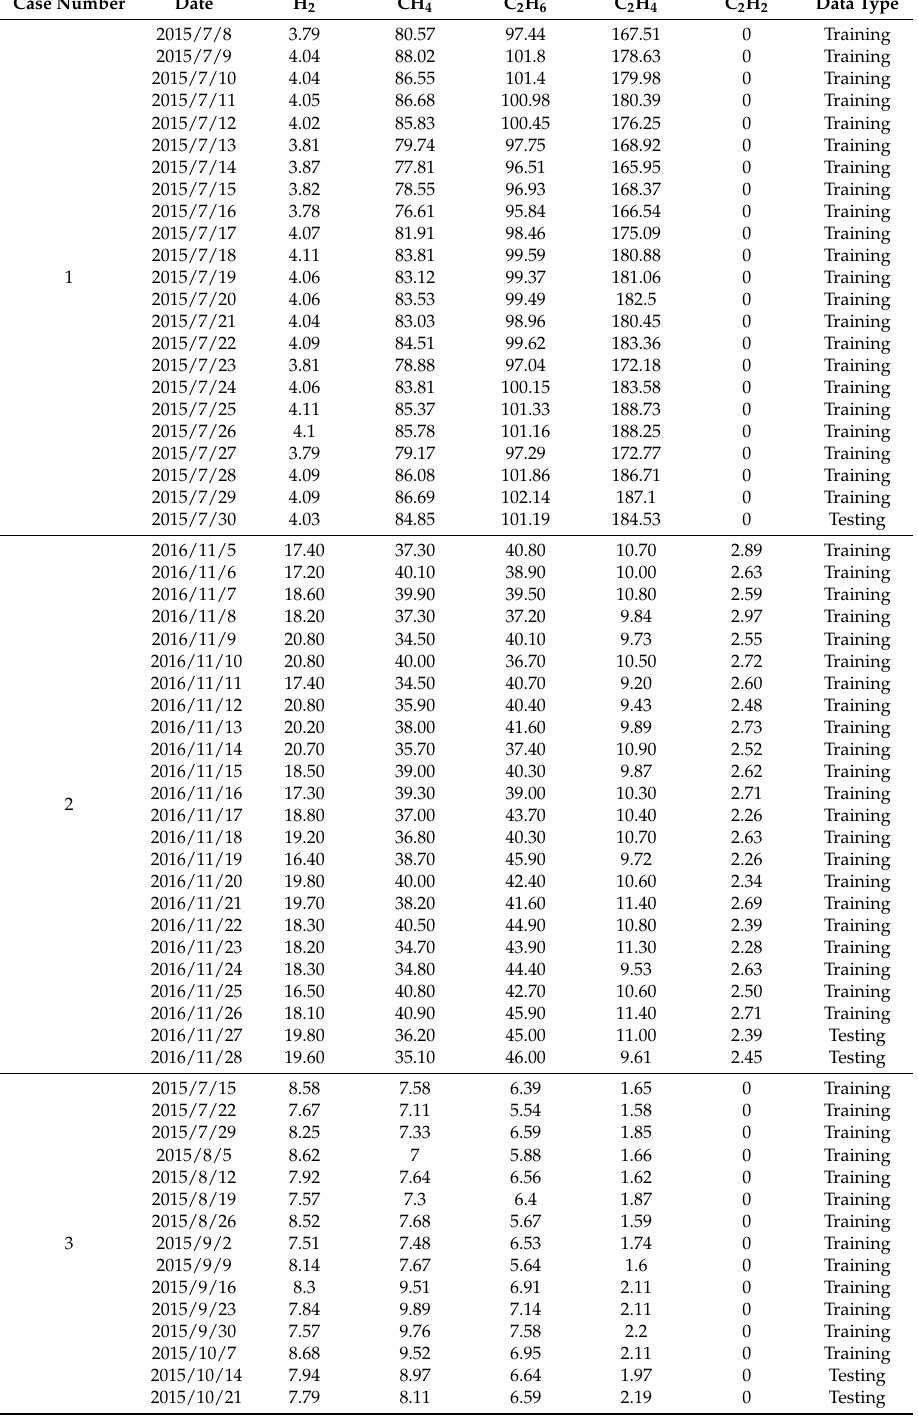
Table 2. The dissolved gas content in a power transformer